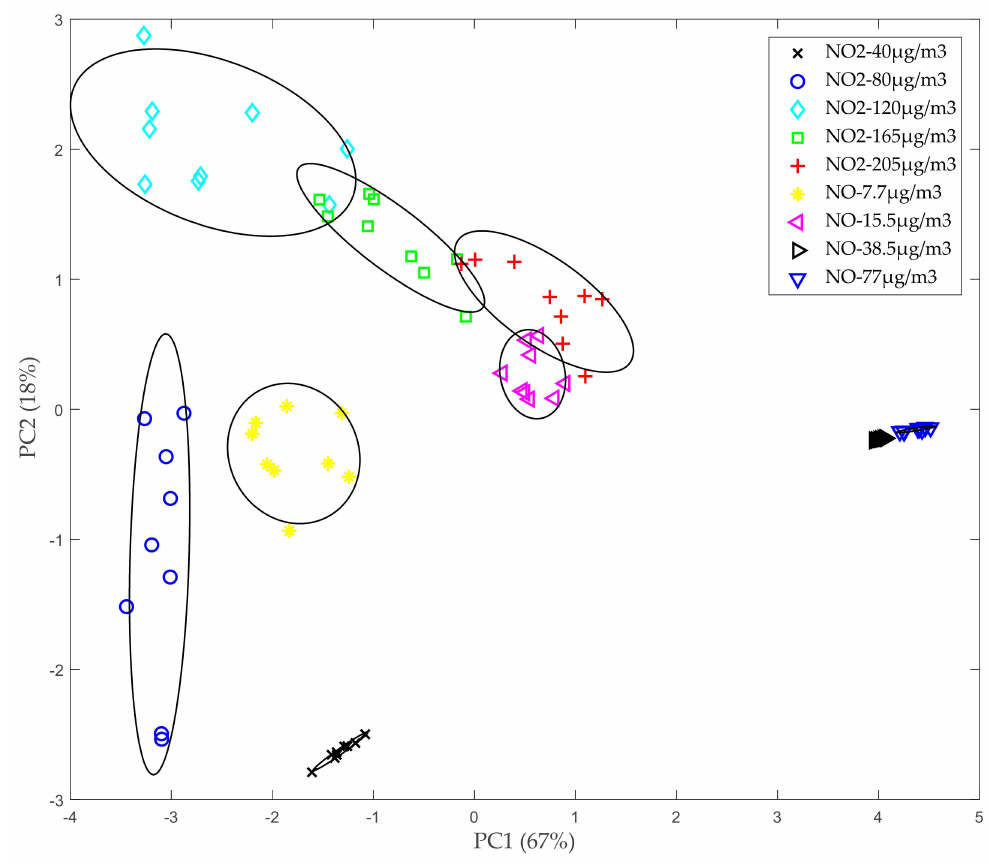
Figure 6. Principal component analysis (PCA)